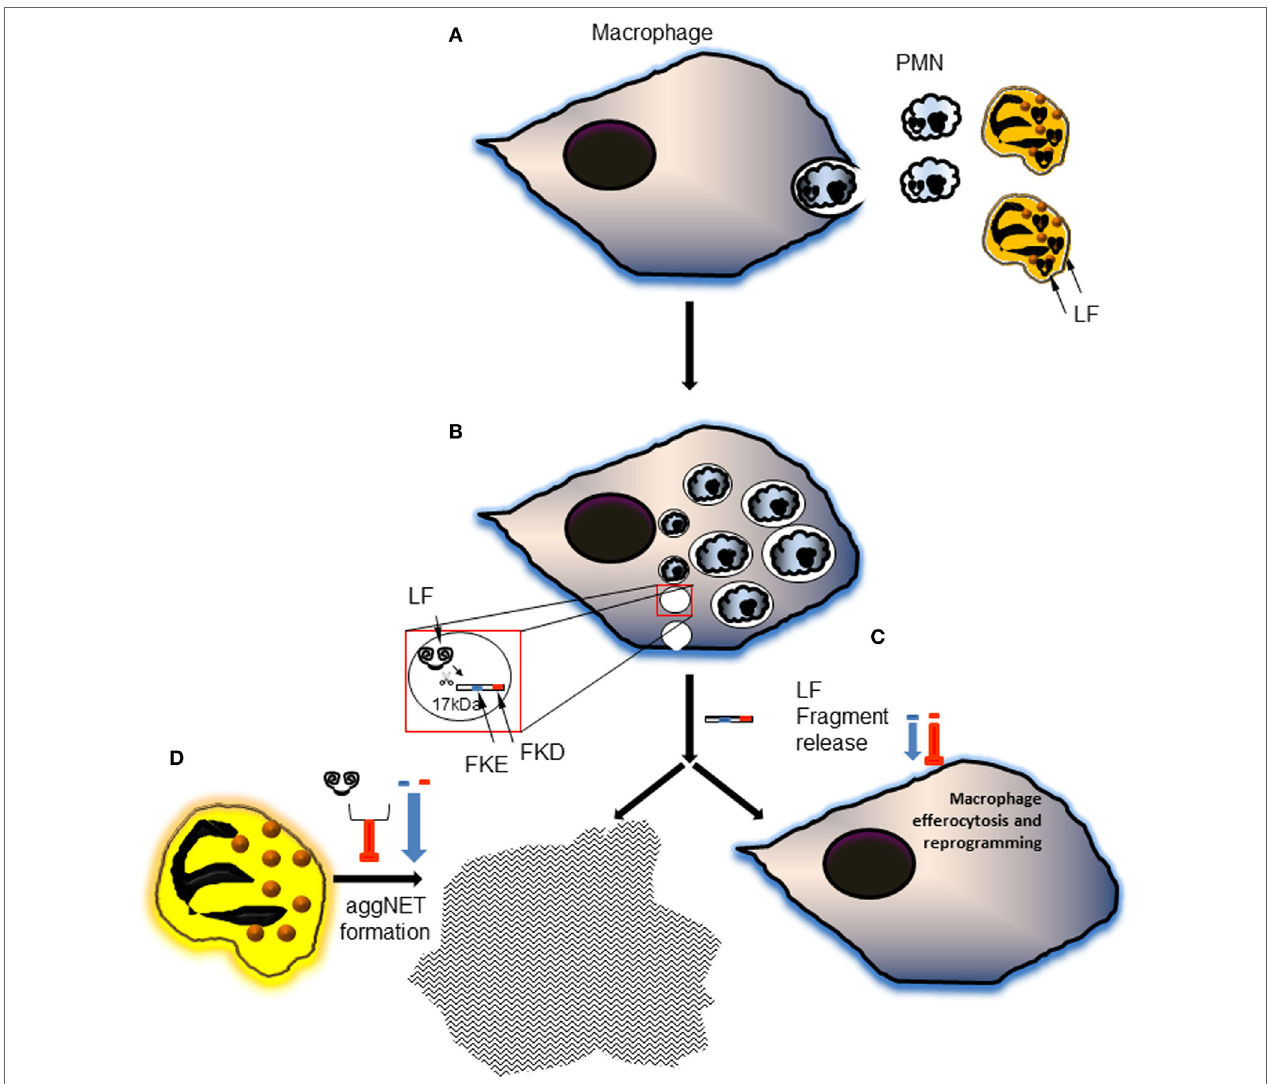
FigUre 7 | A schematic illustration of the proposed model of generation and action of lactoferrin (Lf) fragments and peptides during the resolution of inflammation. (a) During inflammation and its resolution, neutrophils undergo apoptosis and get engulfed by macrophages. This process is accompanied by neutrophil elastase-mediated cleavage of Lf and generation of the 17-kDa fragment. (B) The engulfed polymorphonuclear cell (PMN) corpses traffic to the phagolysosome where most of their cellular components are hydrolyzed. Lf fragments are accumulating in resolution phase macrophages during the inflammatory and resolving phases of the response. 15- and 17-kDa fragments were produced during the inflammatory phase and the resolution of inflammation, respectively. The 17-kDa Lf fragment is released and possibly undergoes further processing to shorter peptides containing the tripeptides FKE and FKD. (c) Both peptides enhance macrophage conversion to the CD11b low phenotype, whereas FKE peptides enhance macrophage efferocytosis in vivo . FKE peptides also promote macrophage reprogramming in vivo culminating in a reduced secretion of tumor necrosis factor α (TNF α ) and interleukin (IL)-6, and an increased secretion of IL-10 upon exposure to LPS. (D) Lf peptides also promote the generation of pro-resolving aggregated neutrophil extracellular traps (aggNETs) in monosodium urate (MSU)-activated human neutrophils, while Lf fails to do so. Intriguingly, when combined with full-length Lf, Lf peptides enhance its inhibition of aggNETs formation following MSU exposure. Altogether, these findings suggest that Lf undergoes specific proteolytic processing to yield functional fragments that are released and “recycled”. These fragments contain bioactive peptides with anti-inflammatory and pro-resolving properties that orchestrate the resolution of neutrophil-driven